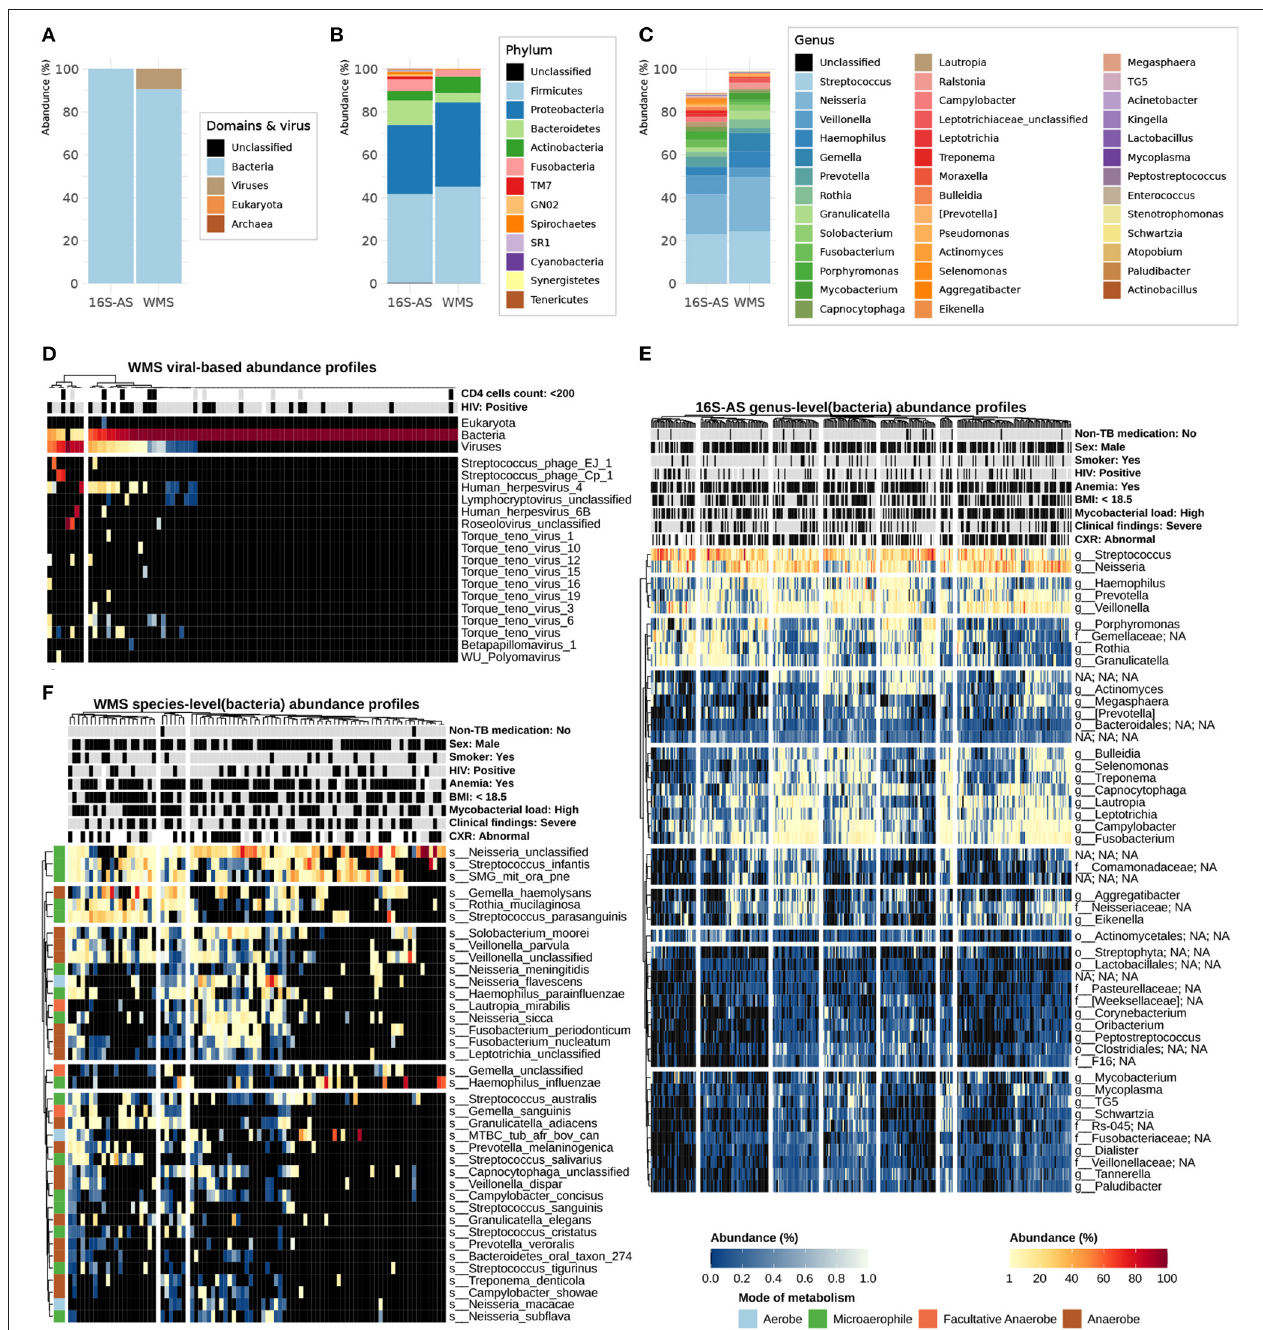
FIGURE 2 | Detailed overview of the sputum microbial composition in TB patients. Per sequencing dataset, mean relative abundances (%) at the domain (including viruses) level (A) , bacterial-phylum level (B) , and bacterial-genus level which includes genera with at least 0.1% relative abundance (C) ; in the legends, below "Unclassified", taxa are arranged from high to low abundance. Heatmap of relative abundances (%) for domains and viruses (D) ; viral composition is break down into species-level components; columns (sputum samples, N = 89) were annotated with the HIV status of the TB patient; taxonomic profiles were derived from WMS-S data. Bacterial composition is break down into species- and genus-level components; species-level abundance profiles were derived from WMS-S data and genus-level abundance profiles were derived from 16S-AS data. Heatmap of bacterial genus-level abundance profiles (E) displays genera detected in at least 50% of sputum samples while heatmap of bacterial species-level abundance profiles (F) displays species detected in at least 15% of sputum samples. Sputum samples and bacterial species/genera are sorted according to hierarchical clustering using Aitchison distances (for additional details, see methods). For the heatmap of bacterial species-level abundance profiles, bacterial species are annotated by reported mode of metabolism. Sputum samples are annotated by different aspects of TB disease manifestations (sputum mycobacterial load, chest X-ray, and clinical findings) and linked demographic and clinical characteristics; annotation labels (variable:level) include the variable’s name and its level displayed in black in the annotation colors, which are gray for alternative levels and white for missing values.